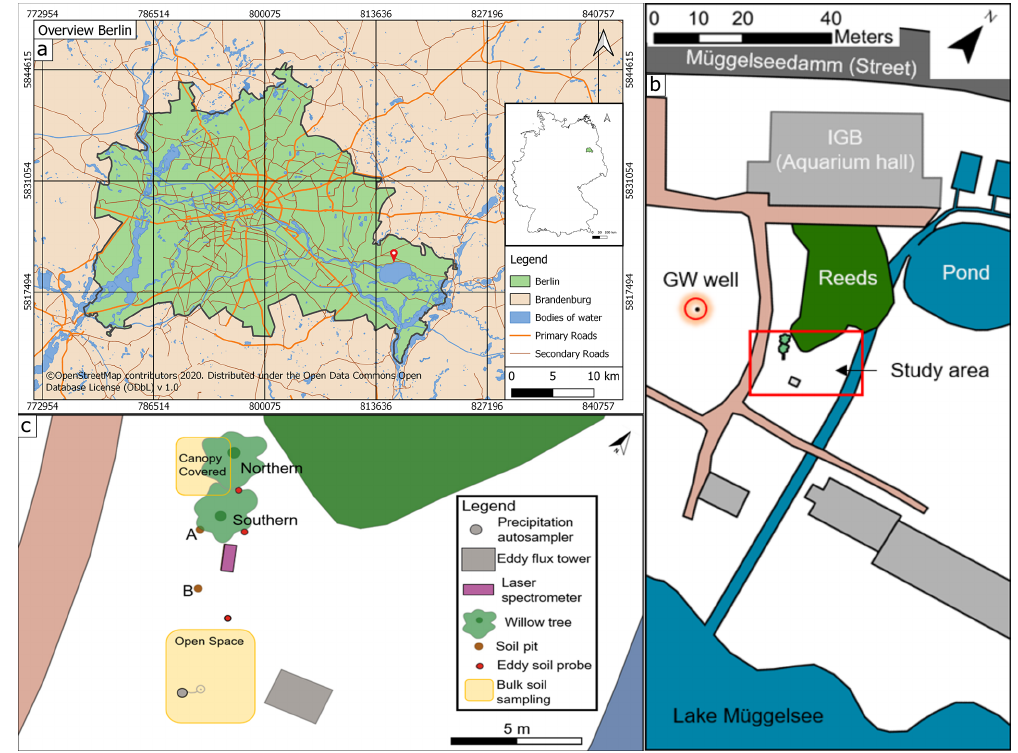
Figure 1. (a) Inner map: location of Berlin in Germany. Outer map: overview of Berlin, with red pin showing the location of the IGB (map data for map in A: © OpenStreetMap contributors, 2020). (b) Sketch of the study site (highlighted by red rectangle) with groundwater (GW) well (highlighted by red circle). (c) Bird’s eye view showing all measuring